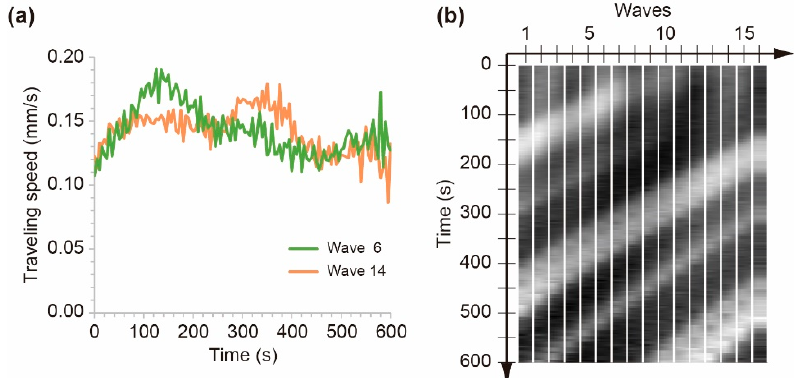
Figure 6. ( a ) Time series of the traveling speed of the chemical waves. ( b ) Time evolution of the spacing from the wave in front. The vertical bars corresponding to each wave. The brightness of each bar indicated the spacing of waves, which were numbered in a clockwise manner from 1 to 16. The width of the bar was appropriately determined and had no meaning.